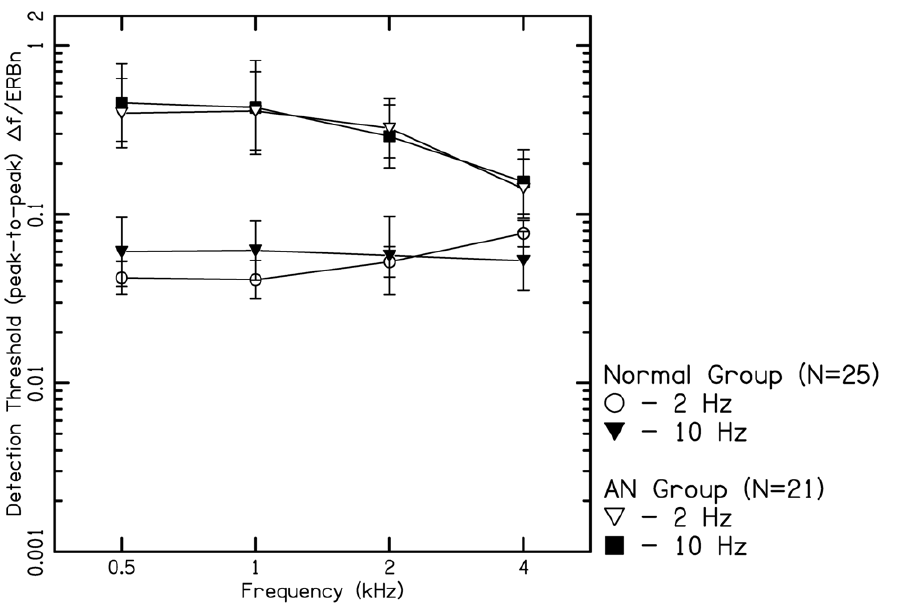
Figure 6. Frequency modulation detection threshold (FMDL) for 2 Hz and 10 Hz modulation frequencies as function of carrier frequencies (0.5, 1, 2, and 4 kHz) expressed as D F divided by equivalent rectangular bandwidth (ERB). D F/ERB values were grossly abnormal at lower frequencies and lean towards normal function at higher frequencies.